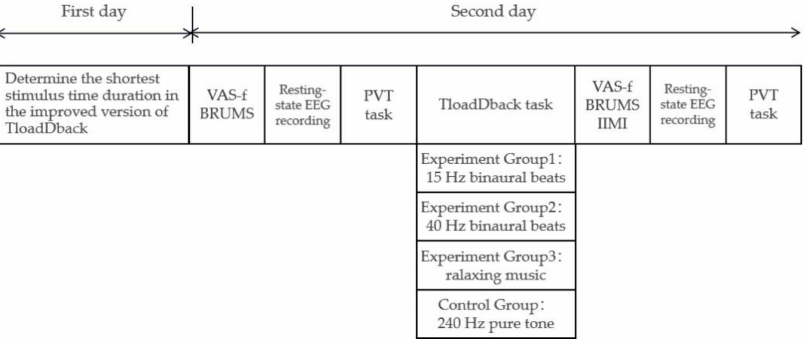
Figure 3. Protocol of formal